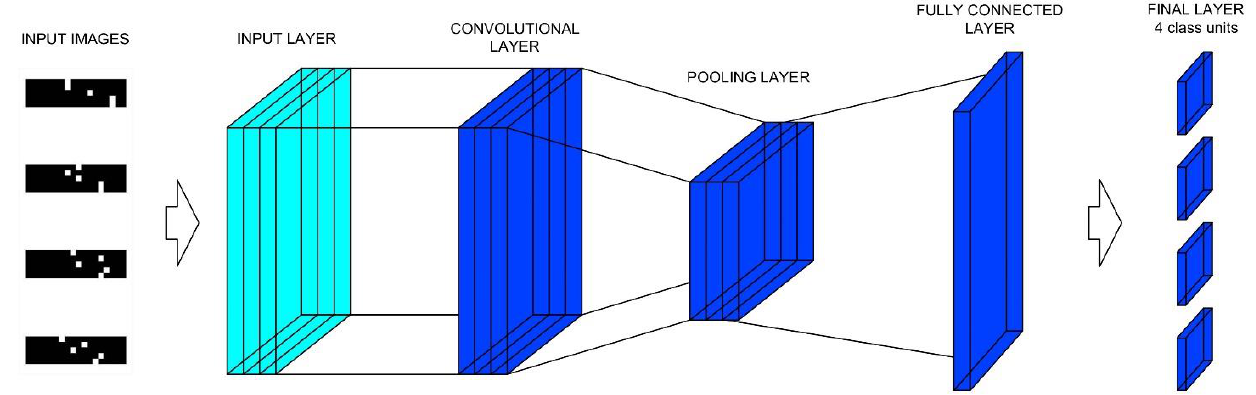
Figure 2. General scheme of a Convolutional Neural